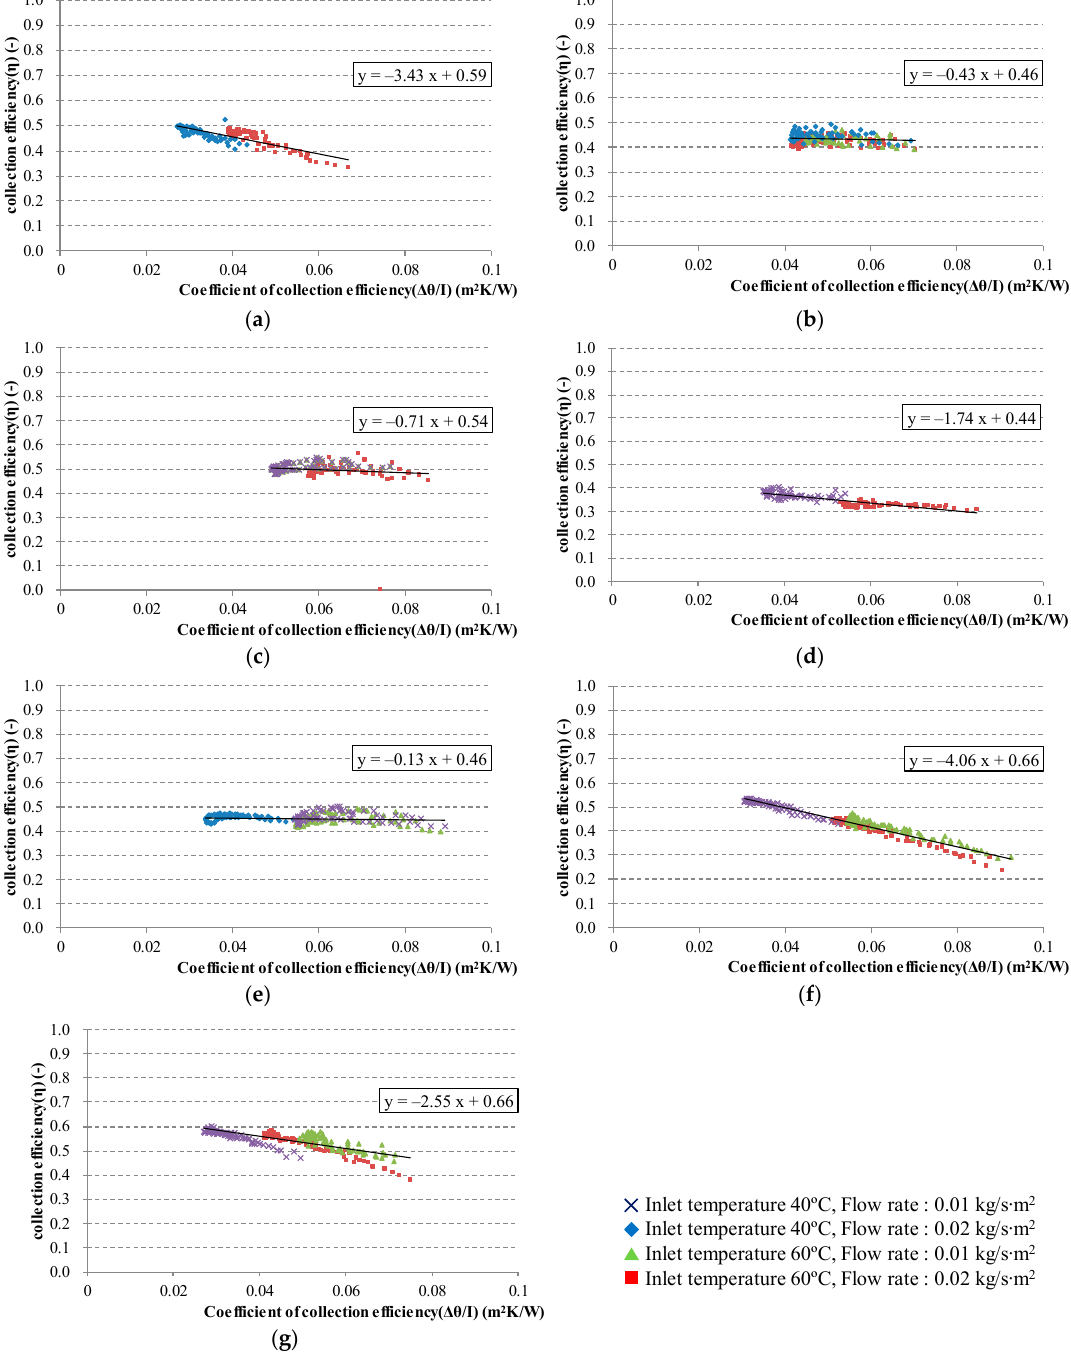
Figure 6. The solar collection efficiency characteristic diagrams of seven types of solar collectors and amount of the annual solar collection. ( a ) Base case; ( b ) Case 1; ( c ) Case 2; ( d ) Case 3; ( e ) Case 4; ( f ) case5; ( g ) Case 6.